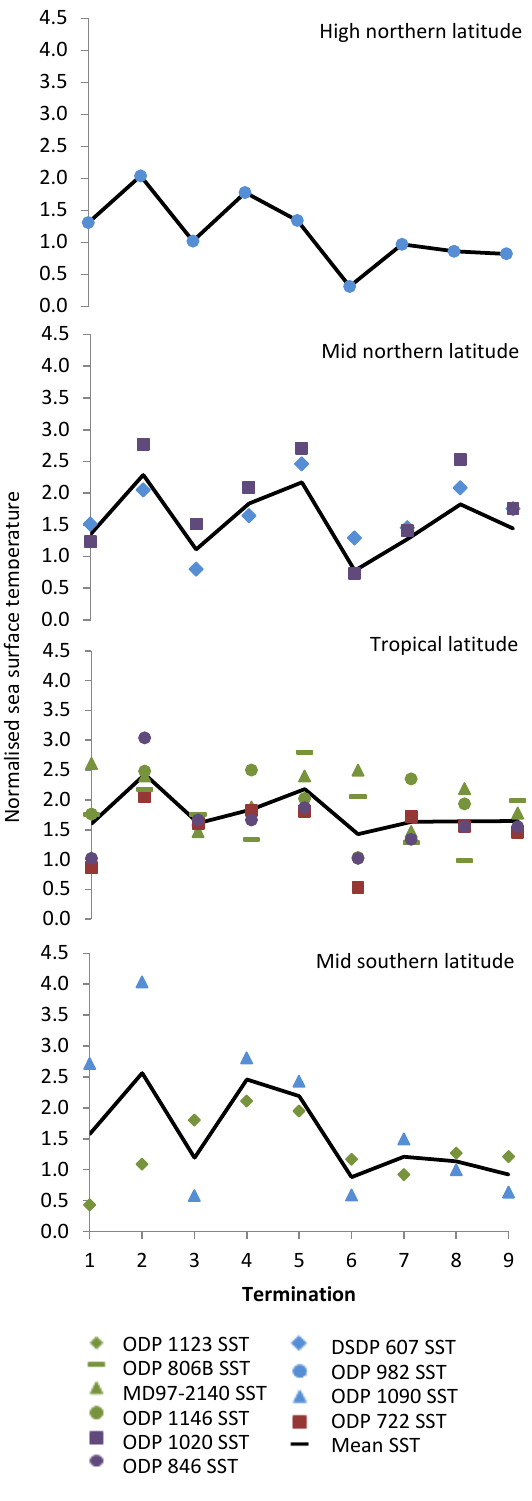
Fig. 5. Normalised peak interglacial values for sea surface tem- perature (SST) grouped by latitude with mean SST values for each